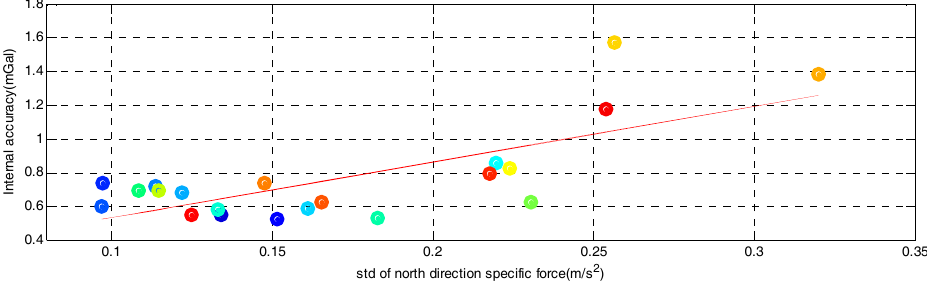
Figure 8. Model residuals.